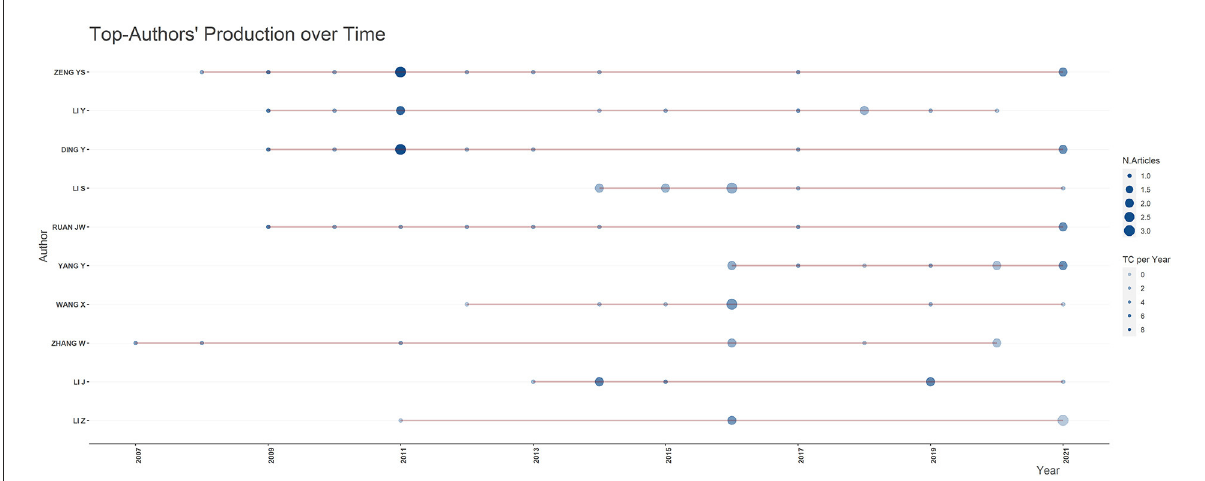
FIGURE4 Publications of the top 10 authors in the field of acupuncture for SCI. (red line, timeline of relevant publications by this author; diameter of circle, number of publications; the shade of blue, total citation per year).